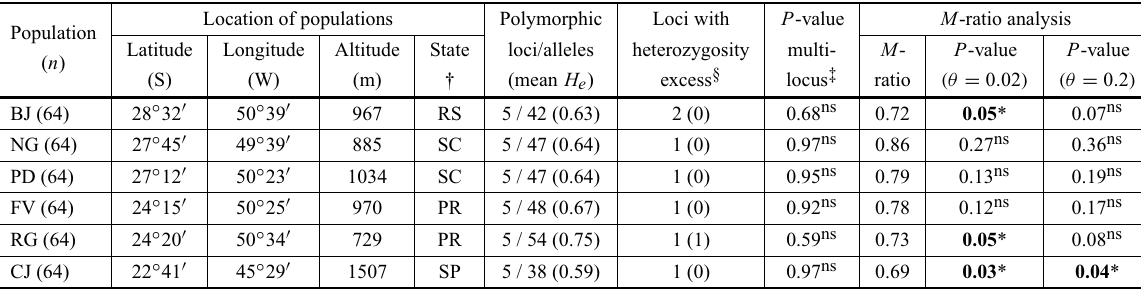
Geographic location of populations and summary of the coalescent-based analyses of microsatellite data. Statistically significant values are highlighted in bold.